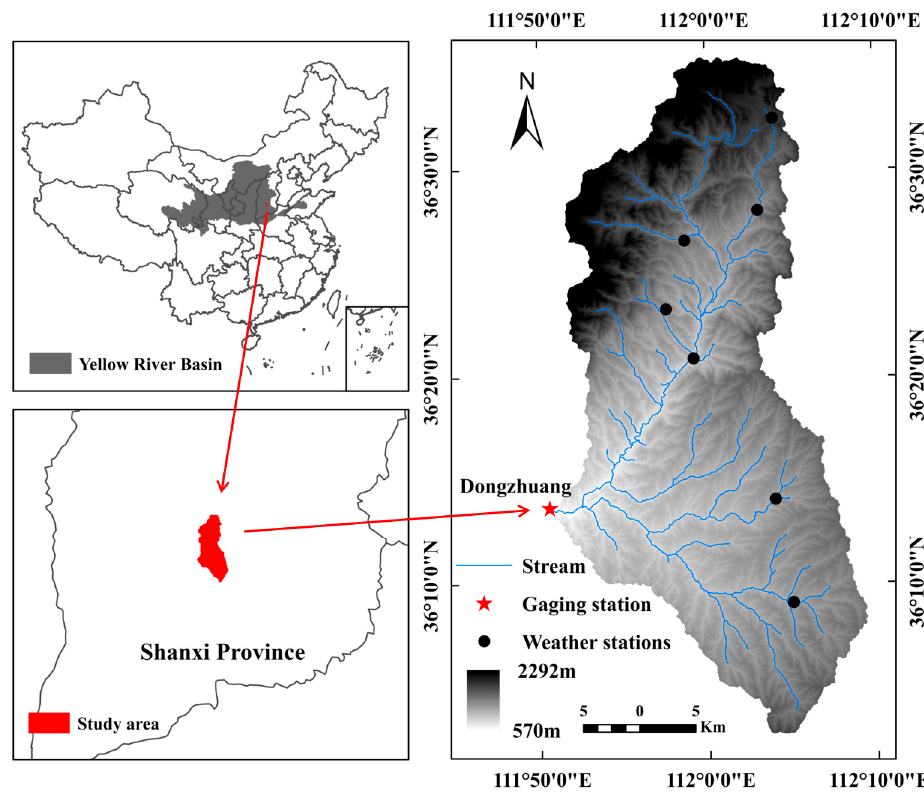
Figure 1. Location of Upper Honganjian watershed with observation stations.